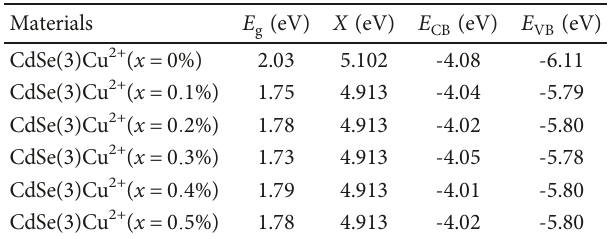
Table 1: The band gap, CB, and VB positions of CdSe:Cu 2+ are calculated by Tauc and UV-Vis